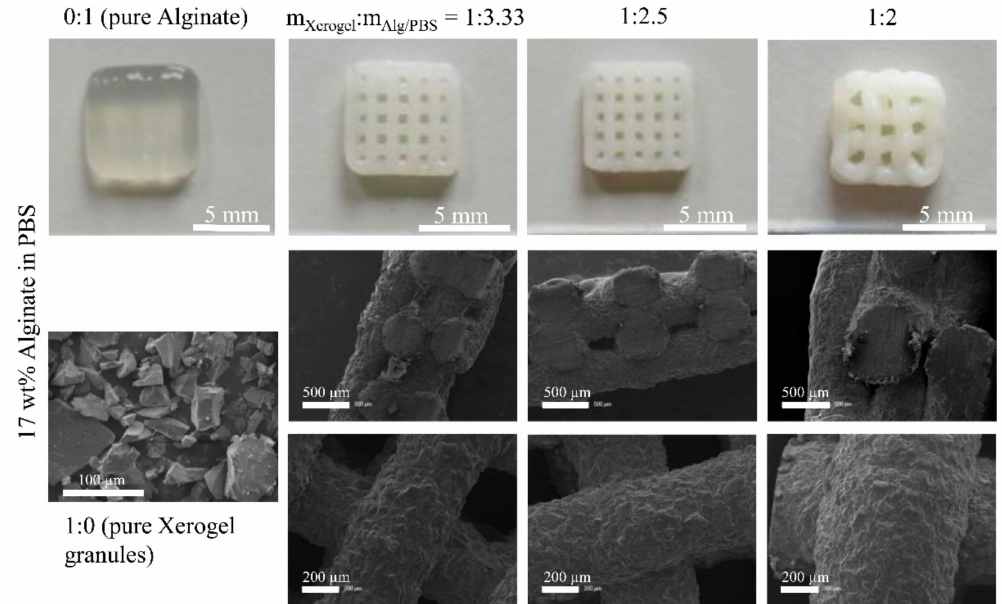
Figure 4. Photographs of 3D plotted biomaterial inks (upper row). Pure alginate (0:1) with 17 wt.% in PBS with little dimensional stability after 3D plotting and plotted composite scaffolds with Xerogel/Alg mass ratios of 1:3.33, 1:2.5, and 1:2. SEM images (lower rows) of pure Xerogel granules (<125 µ m in size), as well as 3D plotted Xerogel/Alg scaffolds. Cross-section (middle row) and surface (lower row) of scaffolds containing a matrix of 17 wt.% alginate in PBS and Xerogel granules with component ratios of 1:3.33, 1:2.5, and